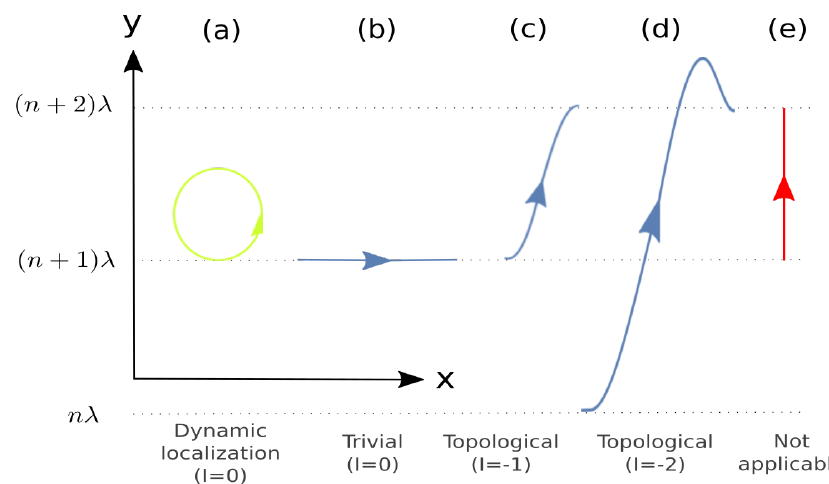
Figure 5: Different paths on x-y plane of the zero curvature of the Euclidean x- independent ShG that represent different single cycles of Rice-Mele model and the respective pumped charge I . The path (a) corresponds to the dynamic localization (See footnote 2 in a previous page). The path (b) is referred as Trivial because the whole evolution is performed by i ˆ A (See Discussion for more). The paths (c),(d) x are the main result of our work, where an exact integer of charge is pumped. Last, the path (e) is not compatible with Theorem